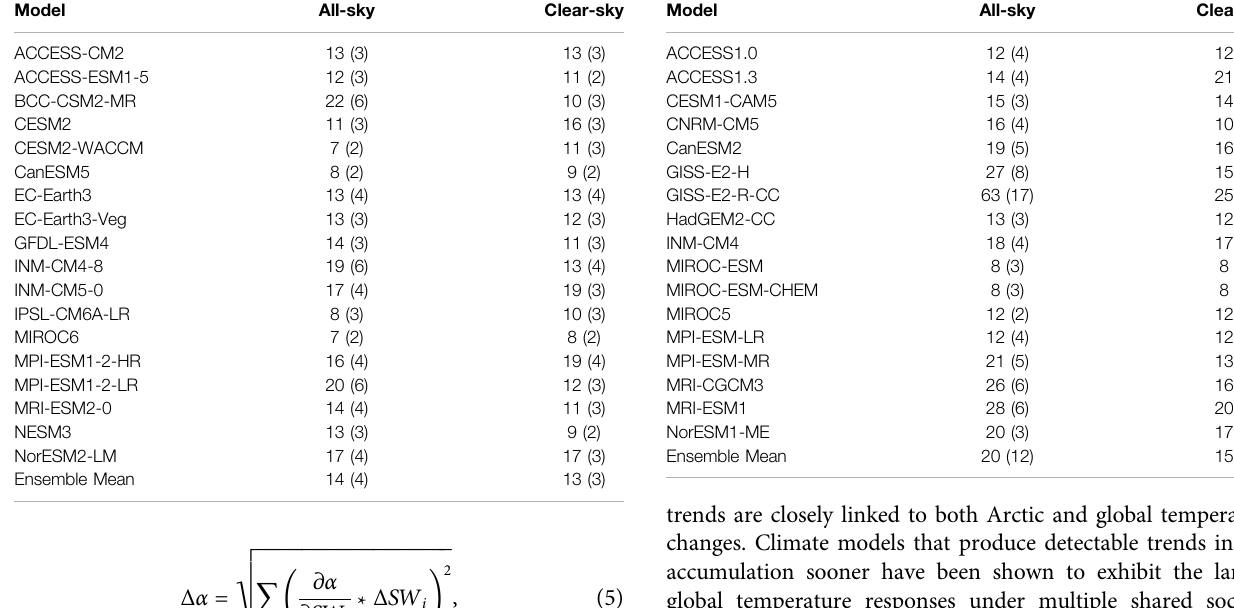
TABLE 4 | Mean TTE in years for all-sky and clear-sky SW acc trends from CMIP6 models. Model All-sky Clear-sky